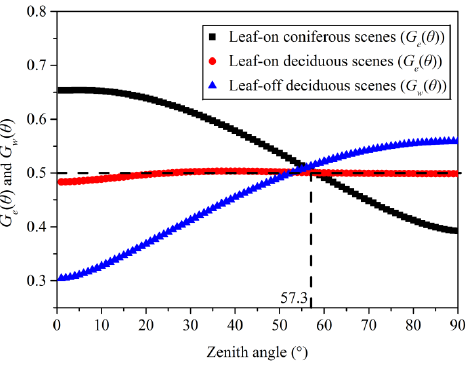
Figure 5. Mean ( ) e G  of all leaf-on coniferous and deciduous scenes and mean ( ) w G  of all leaf- Figure 5. Mean G e ( θ ) of all leaf-on coniferous and deciduous scenes and mean G w ( θ ) of all leaf-off off deciduous scenes. deciduous scenes. Table 3. Mean e PAI of leaf-on coniferous and deciduous scenes, and mean e WAI of leaf-off Table 3. Mean PAI e of leaf-on coniferous and deciduous scenes, and mean WAI e of leaf-off deciduous scenes, which were estimated from the seven inversion models except Miller_0-90 using Equations (3)–(7), (9) and (10) considering G e and G w ( γ e , Ω e ( θ ) , Ω w ( θ ) , Ω e ( θ (cid:48) ) , Ω w ( θ (cid:48) ) , Ω e _ i , and Ω w _ i are assumed to be equal to